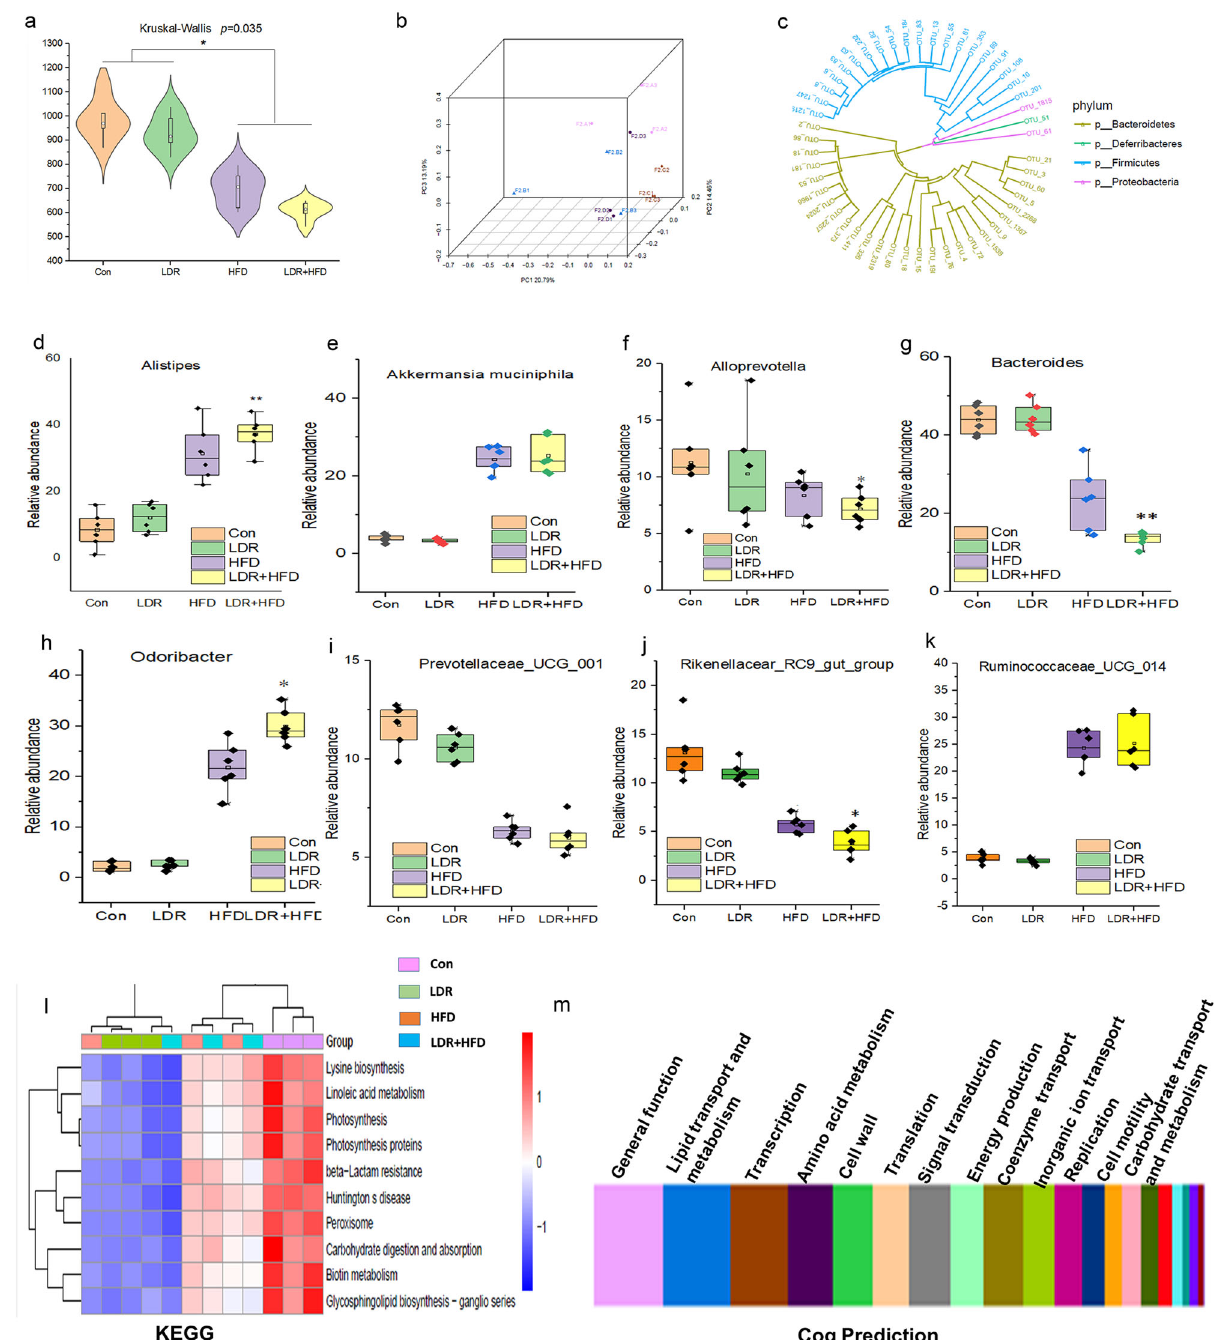
Fig. 3 LDR synergizes with HFD to impact the gut microbiome in mice among the Con, LDR, HFD and LDR + HFD groups. a Total numbers of observed OTUs in the Con, LDR, HFD and LDR + HFD groups ( n = 6 mice in each group). b PCA based on unweighted UniFrac distances and permutational MANOVA (Adonis) was used to test the differences in gut microbiota composition and diversity among groups. c Genus evolutionary tree based on OTUs. d – k The relative abundance values for different genera were determined by analysis of the composition of the faecal microbiome at 21 weeks. FDR- p < 0.05 indicates a signi fi cant difference. The Wilcoxon rank-sum test was adopted for comparisons between groups (* p < 0.05 indicates a signi fi cant difference). l Analysis of the potential KEGG pathways of different representative faecal microbes among the groups at 21 weeks. m Clusters of Orthologous Groups of Proteins (COG) prediction of the potential functions of different representative faecal microbes among the groups at 21 weeks. Error bars indicate SEM (standard error of the